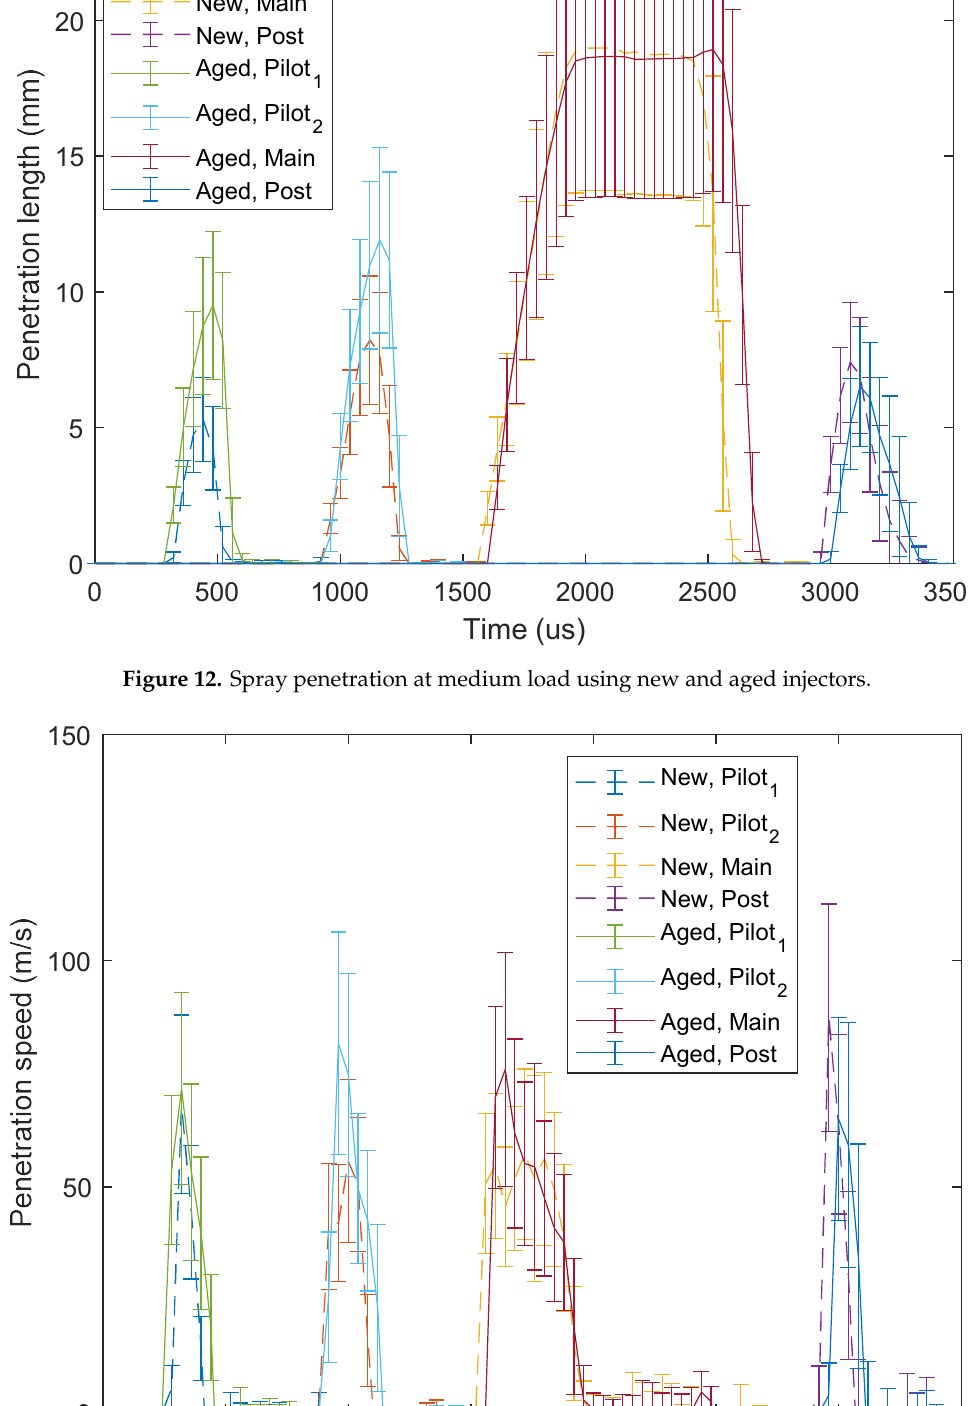
Figure 13. Spray penetration speed at low load with different injectors.